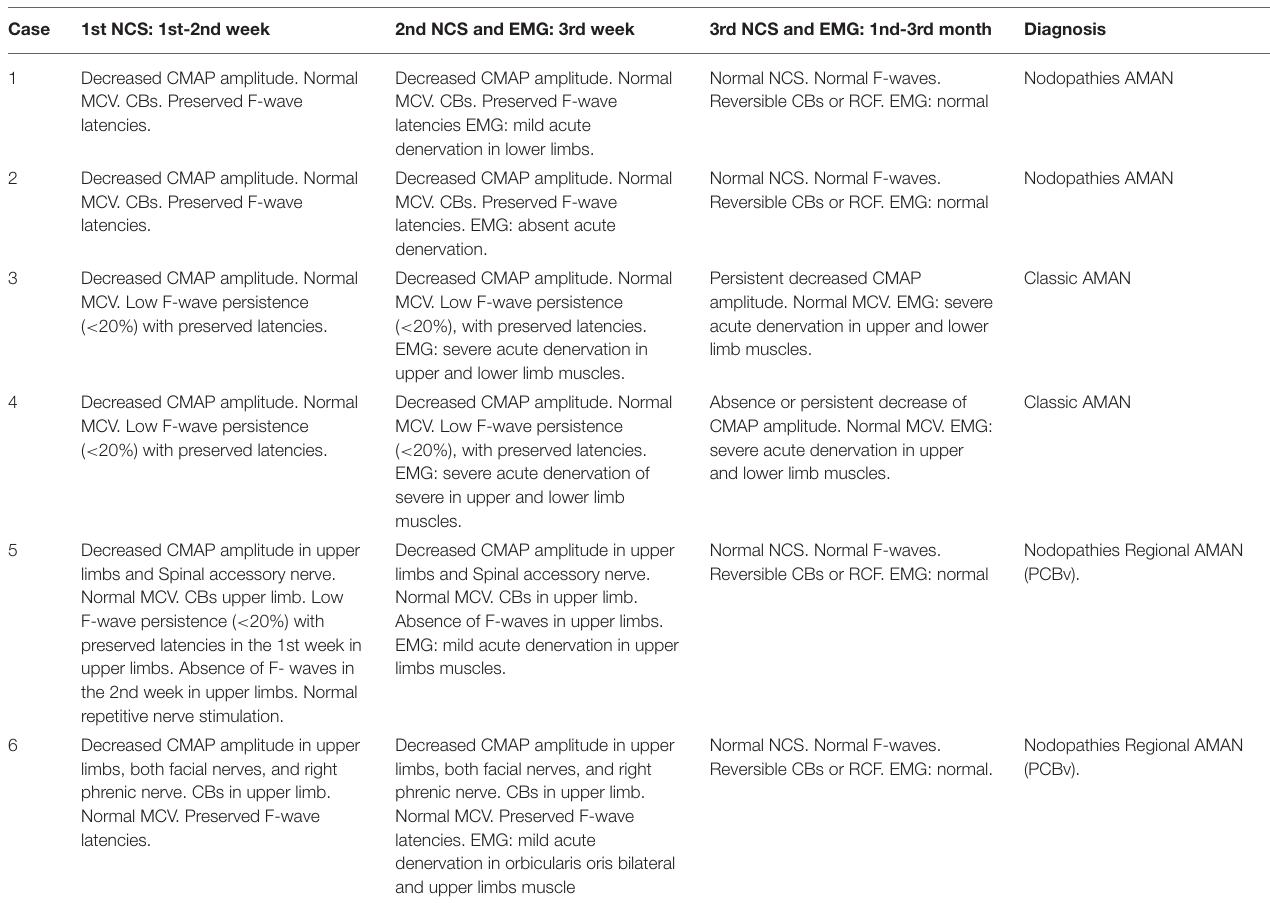
TABLE 2 | Nerve conduction studies (NCS) and electromyography (EMG).